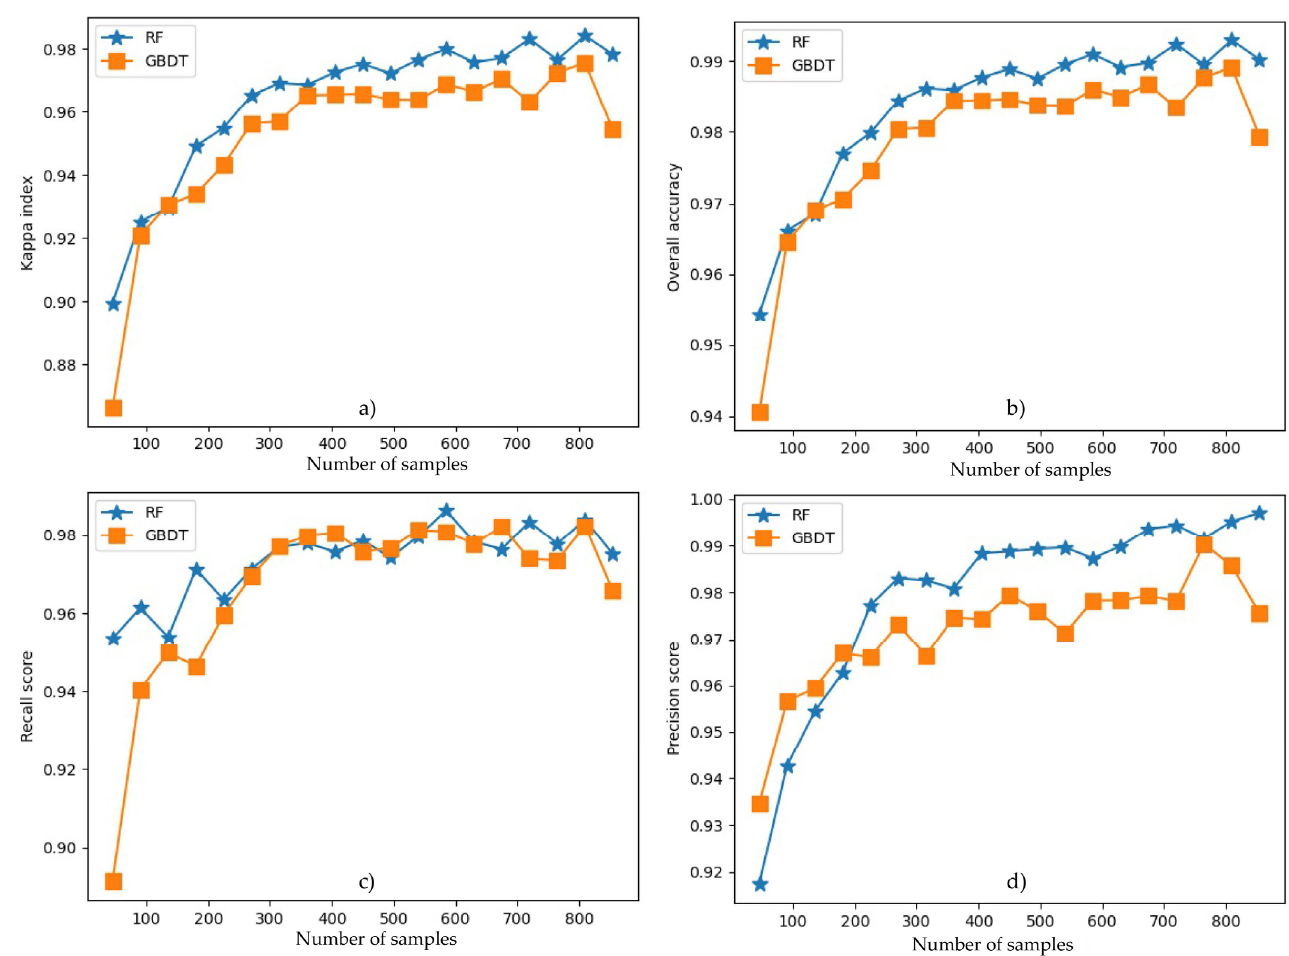
Figure 4. The relationships between the performance of the two classification methods and the number of samples: ( a ) relationship between the Kappa index and the increase of the samples; ( b ) relationship between the overall accuracy and the increase of the samples; ( c ) relationship between the recall score and the increase of the samples; ( d ) relationship between the precision score and the increase of the samples.